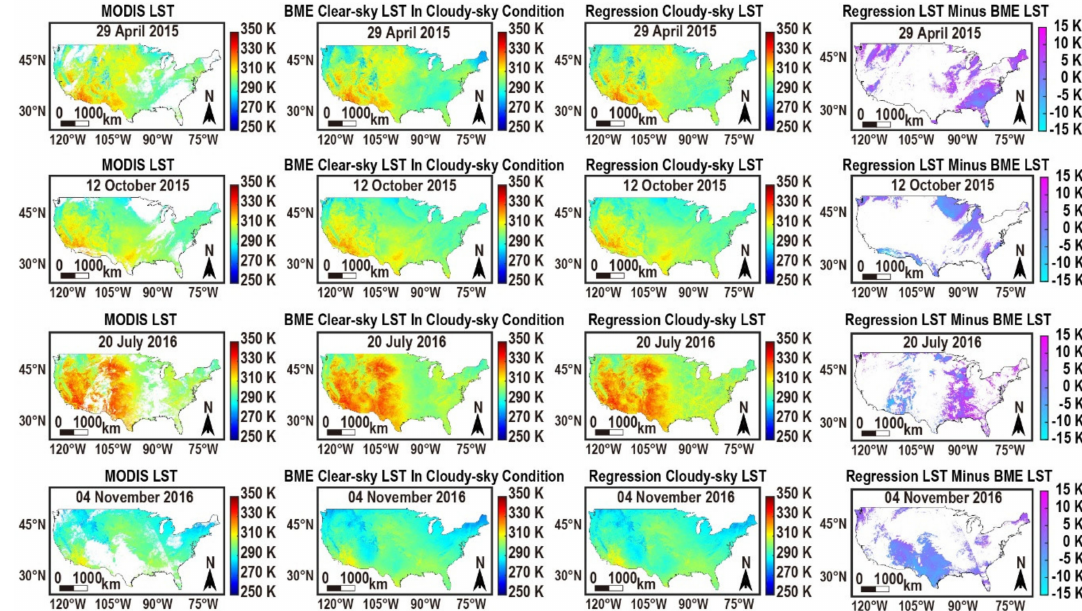
Figure 10. Spatial distribution of MODIS LST ( first column ), BME clear-sky LST in cloudy-sky condition ( second column ), regression cloudy-sky LST ( third column ) and regression cloudy-sky LST minus BME clear-sky LST ( fourth column ) on 29 April 2015 ( first row ); 12 October 2015 ( second row ); 20 July 2016 ( third row ); and 4 November 2016 ( fourth row